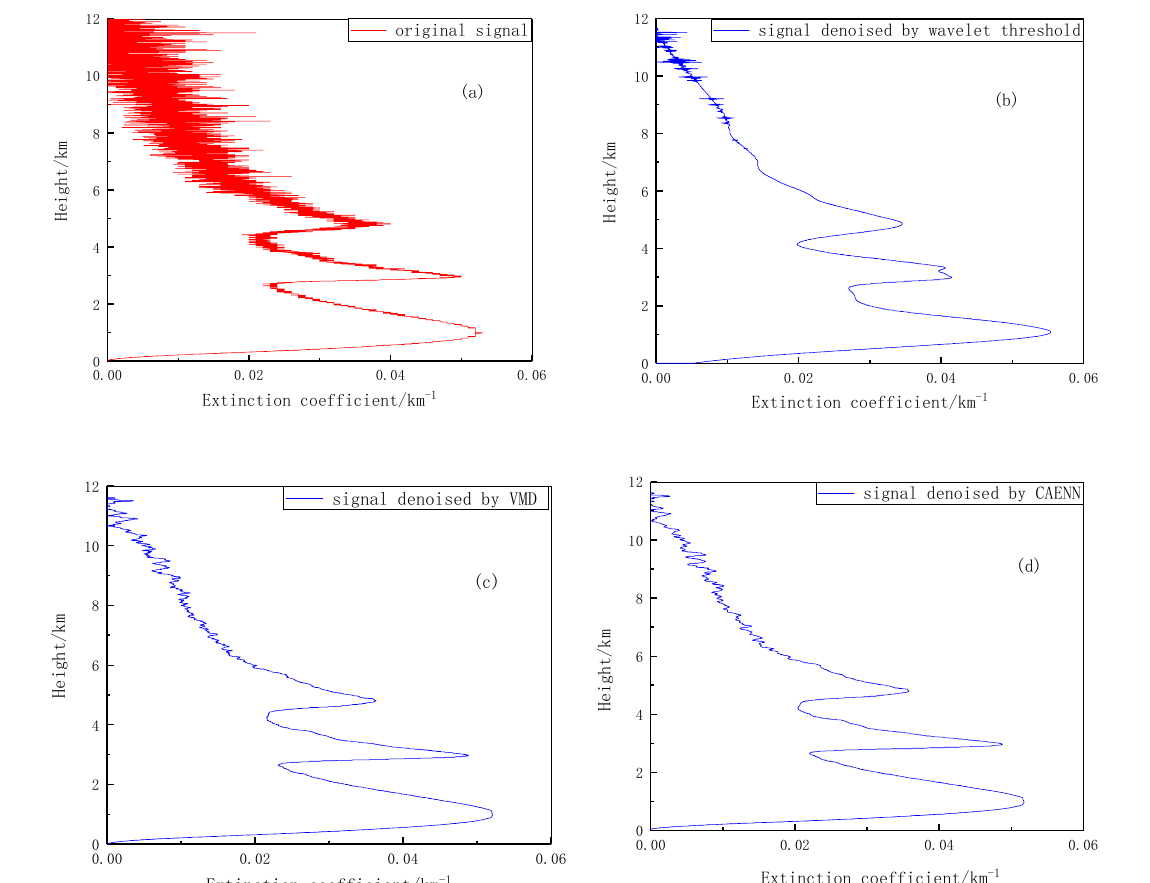
Figure 11. The aerosol extinction coefficient profiles containing two cloud layers obtained by the Klett method and its denoising effect at a wavelength of 532 nm. ( a ) the original signal, ( b ) the signal processed by the wavelet threshold method, ( c ) the signal processed by the VMD method, ( d ) the signal processed by CAENN method. Table 8. The SNR and MSE of signals denoised by three methods shown in Figure 10.